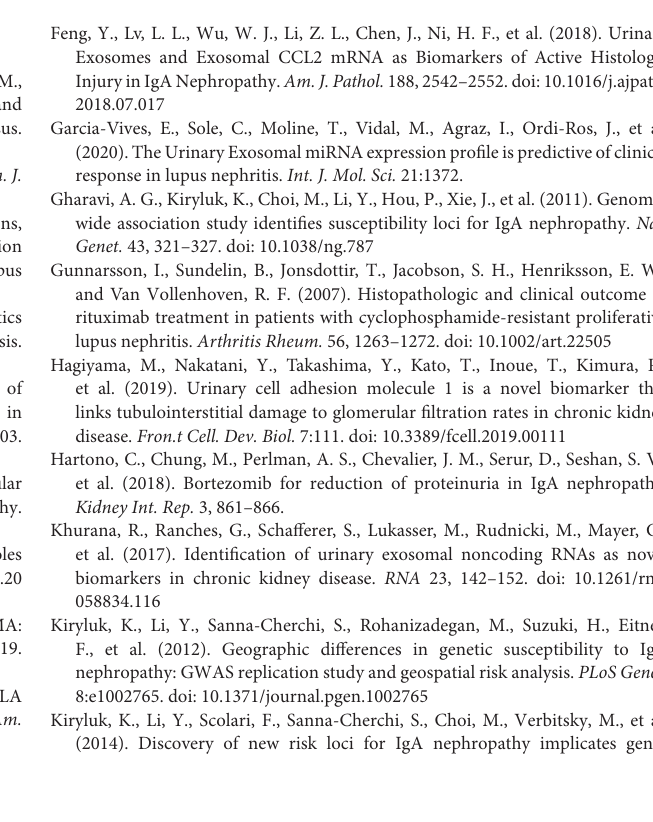
Supplementary Figure 1 | Quality control of expression data from PBMC samples in IgAN. Supplementary Figure 2 | Quality control of expression data from PBMC samples in SLE. Supplementary Figure 3 | Quality control of expression data from glomerular samples in IgAN. Supplementary Figure 4 | Quality control of expression data from glomerular samples in LN. Supplementary Figure 5 | Quality control of expression data from renal tubular samples in IgAN. Supplementary Figure 6 | Quality control of expression data from renal tubular samples in LN. From Supplementary Figure 1 to Supplementary Figure 6 , for each microarray dataset, we show several quality control plots, including expression boxplots and histograms. Outlier detection was determined based on standardized network connectivity Z -scores. Multidimensional scaling (MDS) plots show sample clustering by the first two expression principal components. Groups were balanced by available covariates and potential confounding factors. Supplementary Table 1 | Gene expression microarray datasets included in this